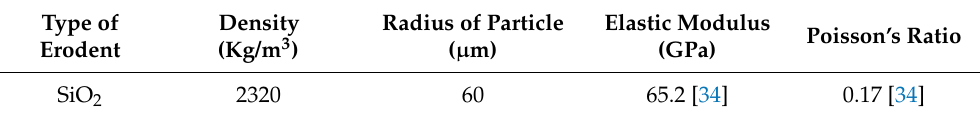
Table 1. Parameters of silica erodent at ambient